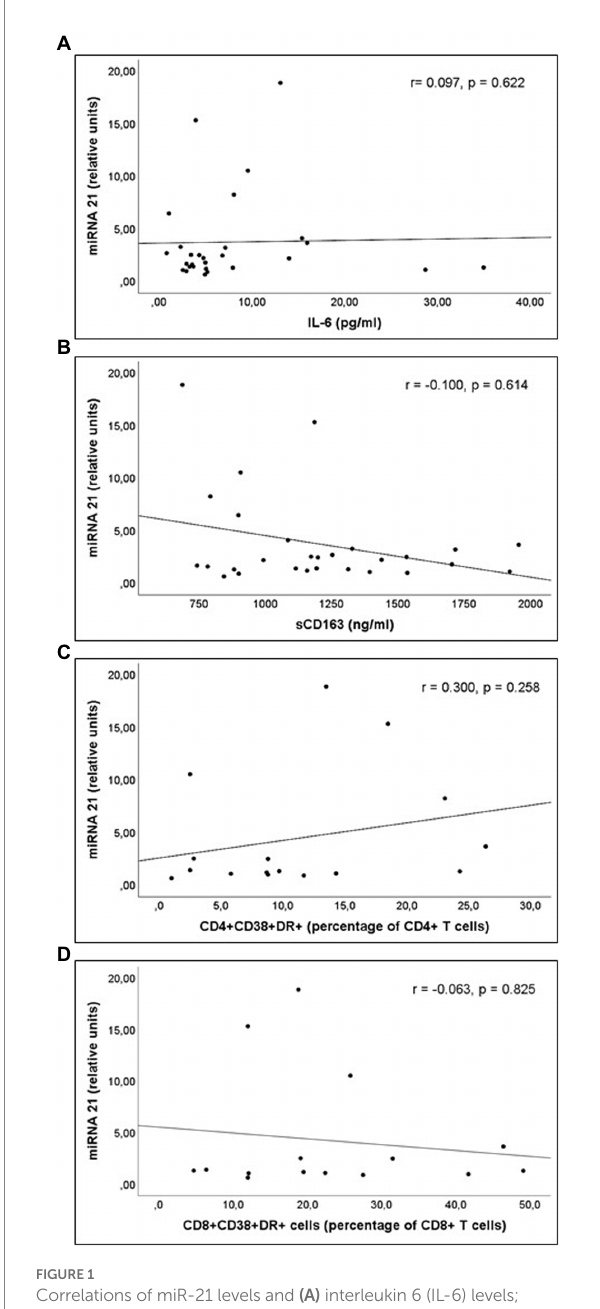
FIGURE 1 Correlations of miR-21 levels and (A) interleukin 6 (IL-6) levels; (B) soluble CD163 (sCD163) levels; (C) CD4+CD38+DR+ percentage of CD4+ T cell lymphocytes; and (D) CD8+CD38+DR+ percentage of CD8+ T cell lymphocytes count, in untreated people living with